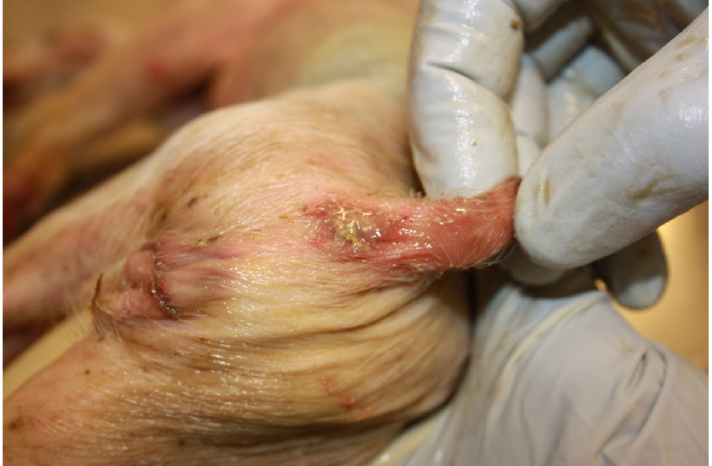
Figure 5. Suckling piglet suffering from colibacillosis. Characteristic wet hair coat and inflammation of anus.